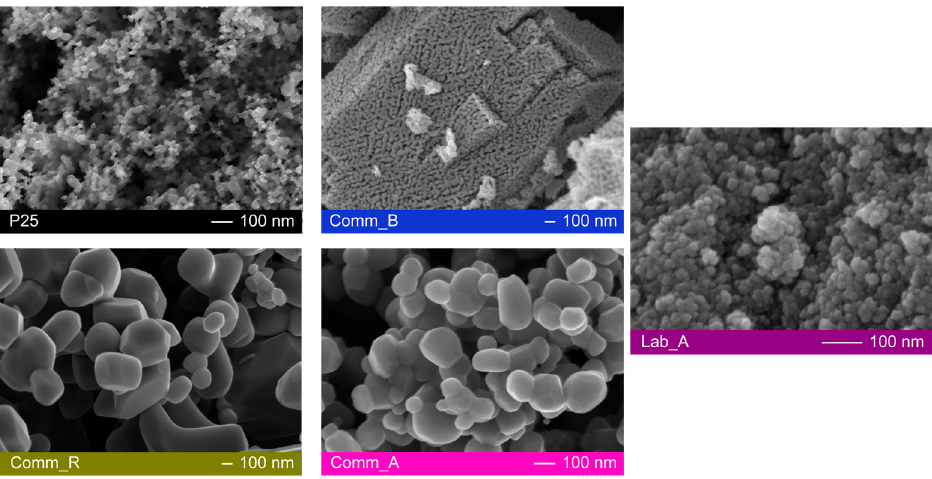
Figure 2. Selected FESEM micrographs of the studied powder samples, showing particles with different sizes, morphology, and agglomeration/aggregation.